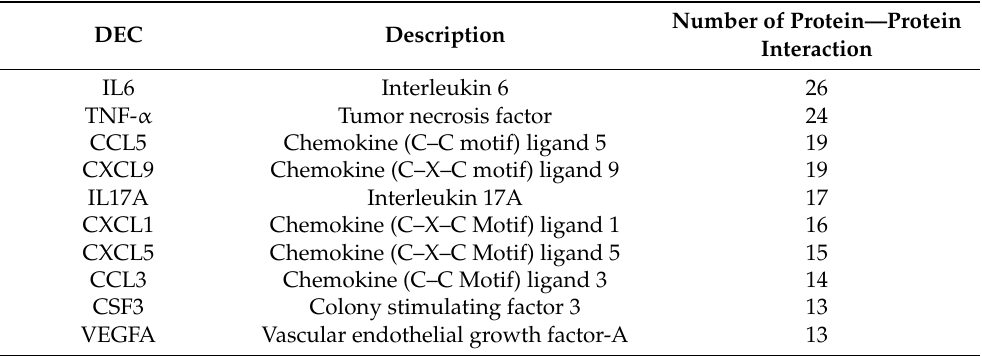
Table 2. Summary of the top 10 key differentially expressed cytokines (DECs) based on protein- protein interaction analysis.